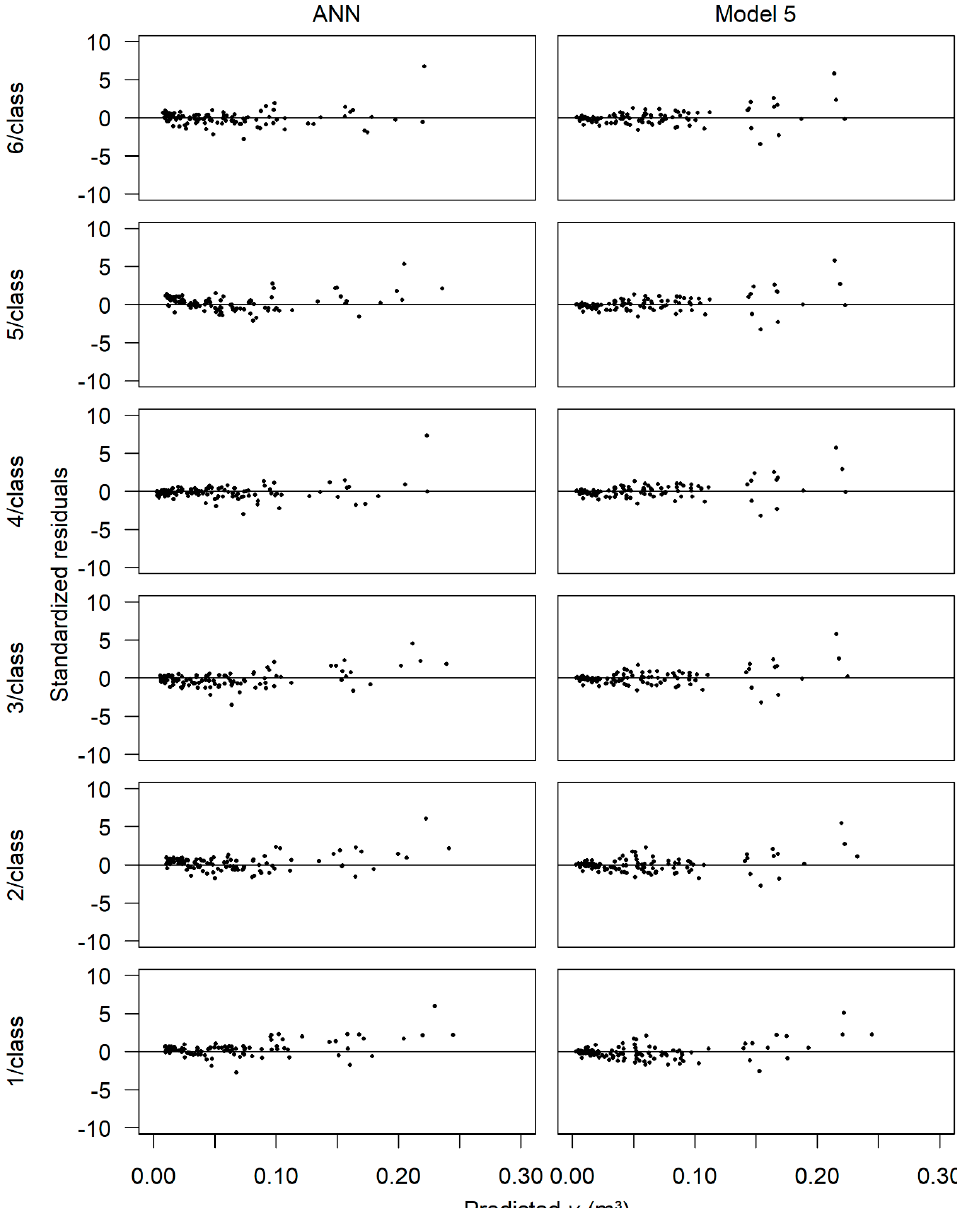
Figure 7. Dispersion of the standardized residuals as a function of the predicted commercial volume